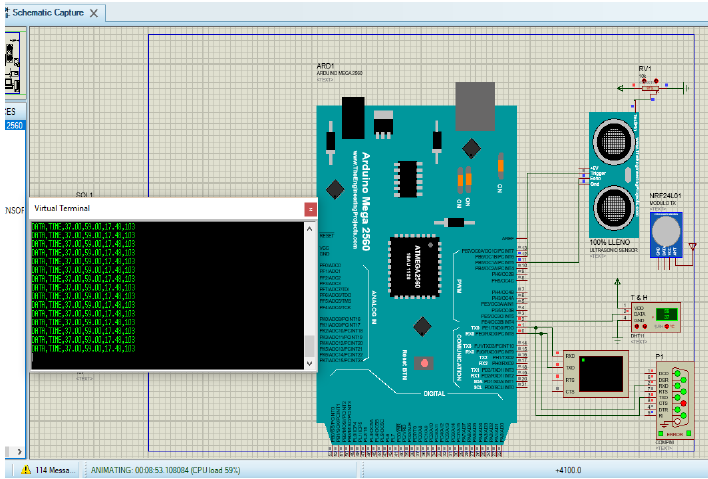
Figure 7. NS and Gateway Nodes (NG) operation.